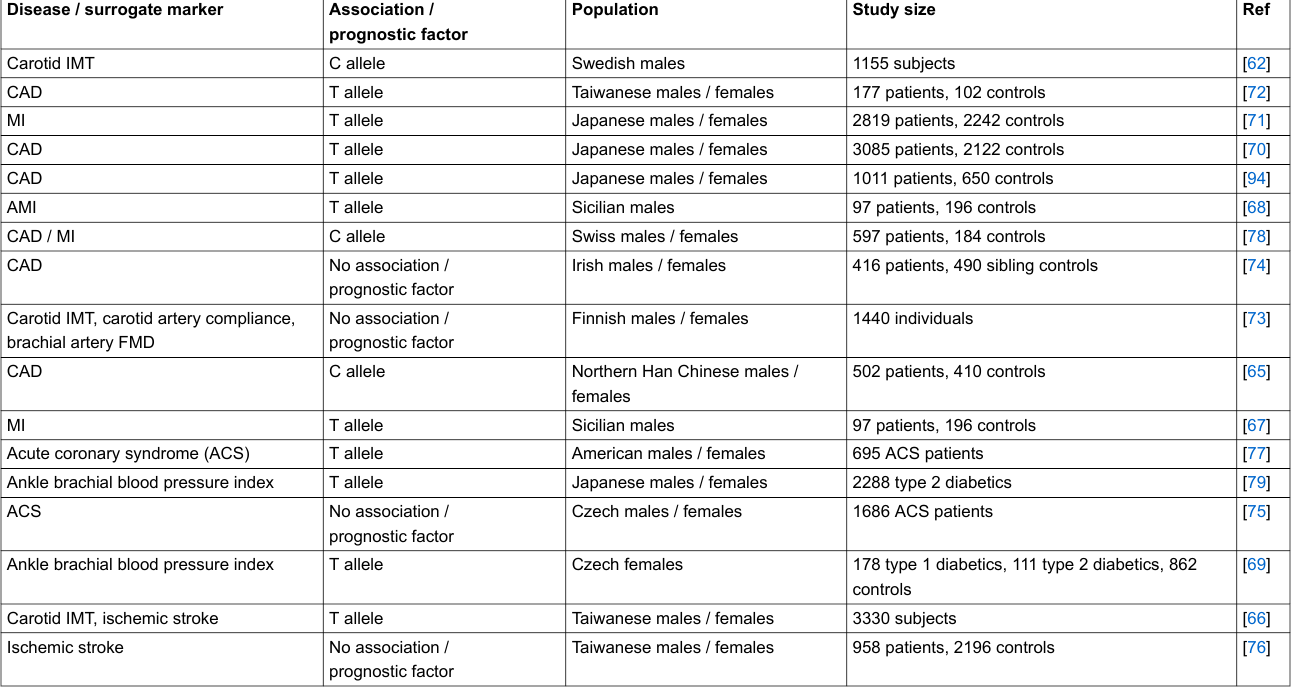
Table 2: Overview of studies on possible associations between the GJA4 SNP and diseases involving, at least to some extent, atherosclerosis. Disease / surrogate